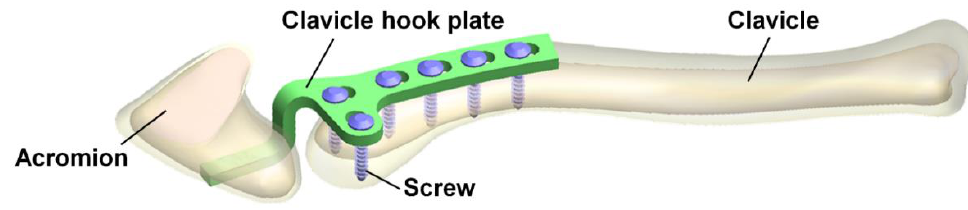
Figure 1. The four parts included the clavicle, acromion, clavicle hook plate, and six screws.